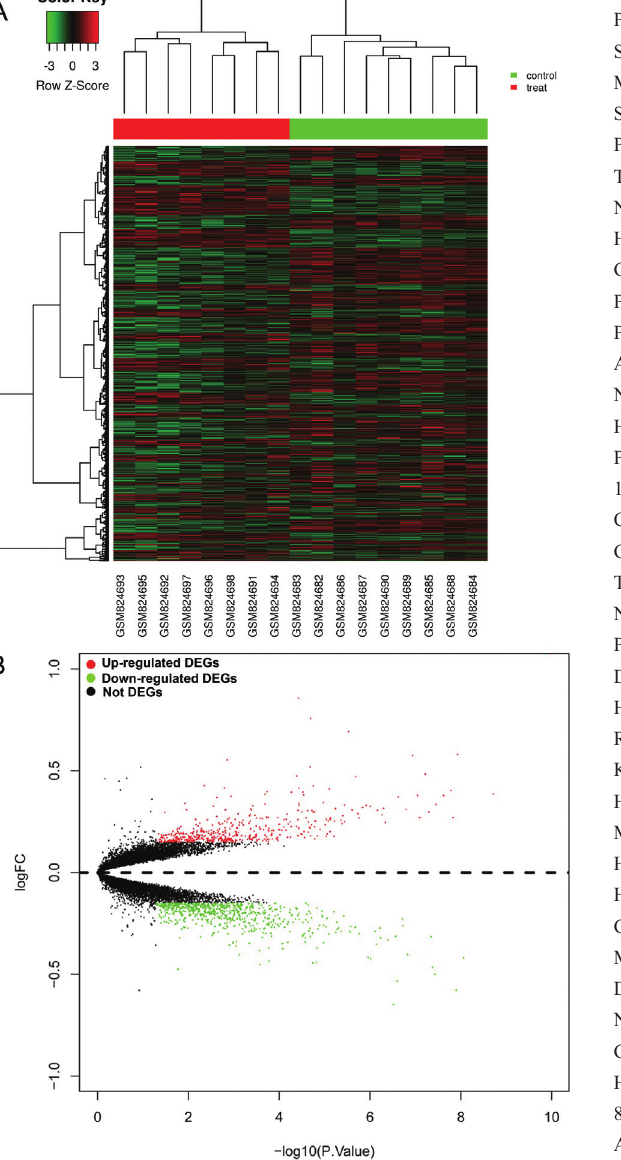
Figure 2 - The DEGs in sleep deprivation mice compared with non-sleep- deprivedcontrolmice.A:Heatmapanalysis.B:Volcanoplotanalysis.Green represents down-regulated. DEGs, red represents up-regulated DEGs.